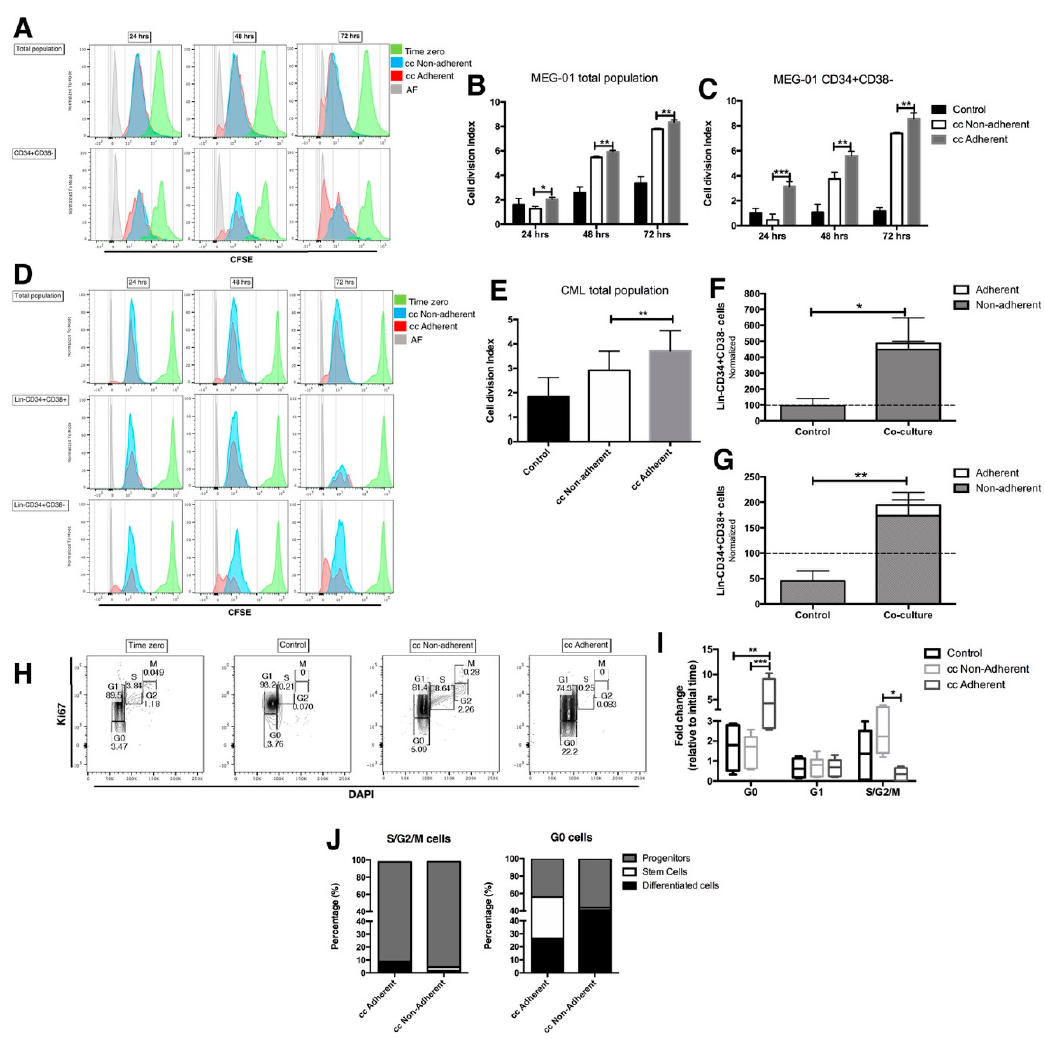
Figure 3. The endothelial microenvironment could induce proliferation and cell arrest in CML stem cells: Cells from CML were co-cultured in contact with EC for three days in absence of any cytokines to evaluate proliferation at different times (using CFSE staining) or cell cycle staining after three days (through Ki67 and DAPI incorporation). ( A ) Representative histograms of CFSE assay at 24, 48 and 72 h of culture in total or stem cell populations from MEG-01 cell line or ( D ) primary CML sample. Cell division index in ( B ) bulk and ( C ) stem cell population (CD34+CD38-) of MEG-01 cell line at 24, 48 and 72 h of co-culture. ( E ) Primary CML total cells after three days of co-culture. Number of cells with ( F ) stem (Lin-CD34+CD38-) and ( G ) progenitor (Lin-CD34+CD38+) immunophenotype after 72 h of co-culture. Cell number was normalized with respect to the initial number of progenitor and stem cells in each sample used. ( H ) Representative dot plots of one CML sample after three days in the different co-culture conditions. ( I ) Fold change of cell cycle phases, relative to time zero of each sample used. ( J ) Percentage of different hematopoietic subpopulations in each co-culture condition and cell cycle phase. The data are expressed as mean ± SEM or only the mean of 3–6 independent experiments in triplicate. * p ≤ 0.05, ** p ≤ 0.005, *** p ≤ 0.0005. All these results suggest that the endothelial microenvironment could induce prolif- eration and/or quiescence in CML stem cells and this could be related to the type of inter- actions that are established between both cell linages. Interestingly, 29.5% of the cells in G0, and that were attached to EC, showed a stem cell phenotype; in contrast, only 2.7% of G0 cells in the non-attached fraction showed a stem cell phenotype (Figure 3j). Moreover, cells with a stem cell phenotype were not observed in the active cell cycle phases (S/G2/M), where the highest percentage (90%) corresponded to progenitor cells (Figure